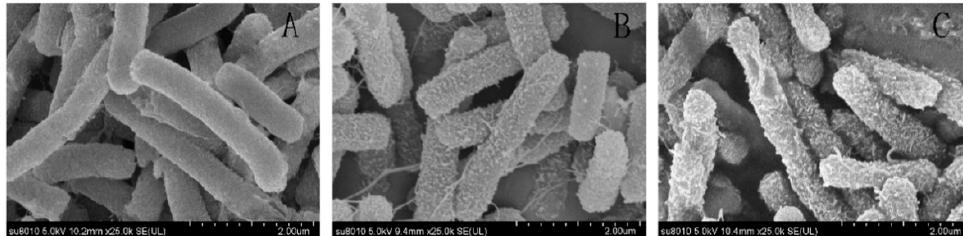
Figure 10. Scanning electron micrographs of E. coli ATCC25922 treated with HV2 and PG-1. ( A ) Control, no peptides; ( B ) HV2-treated, 8 µ M; ( C ) PG-1-treated, 4 µ M. Bacteria were treated with peptides at 1 × MIC for 1 h.